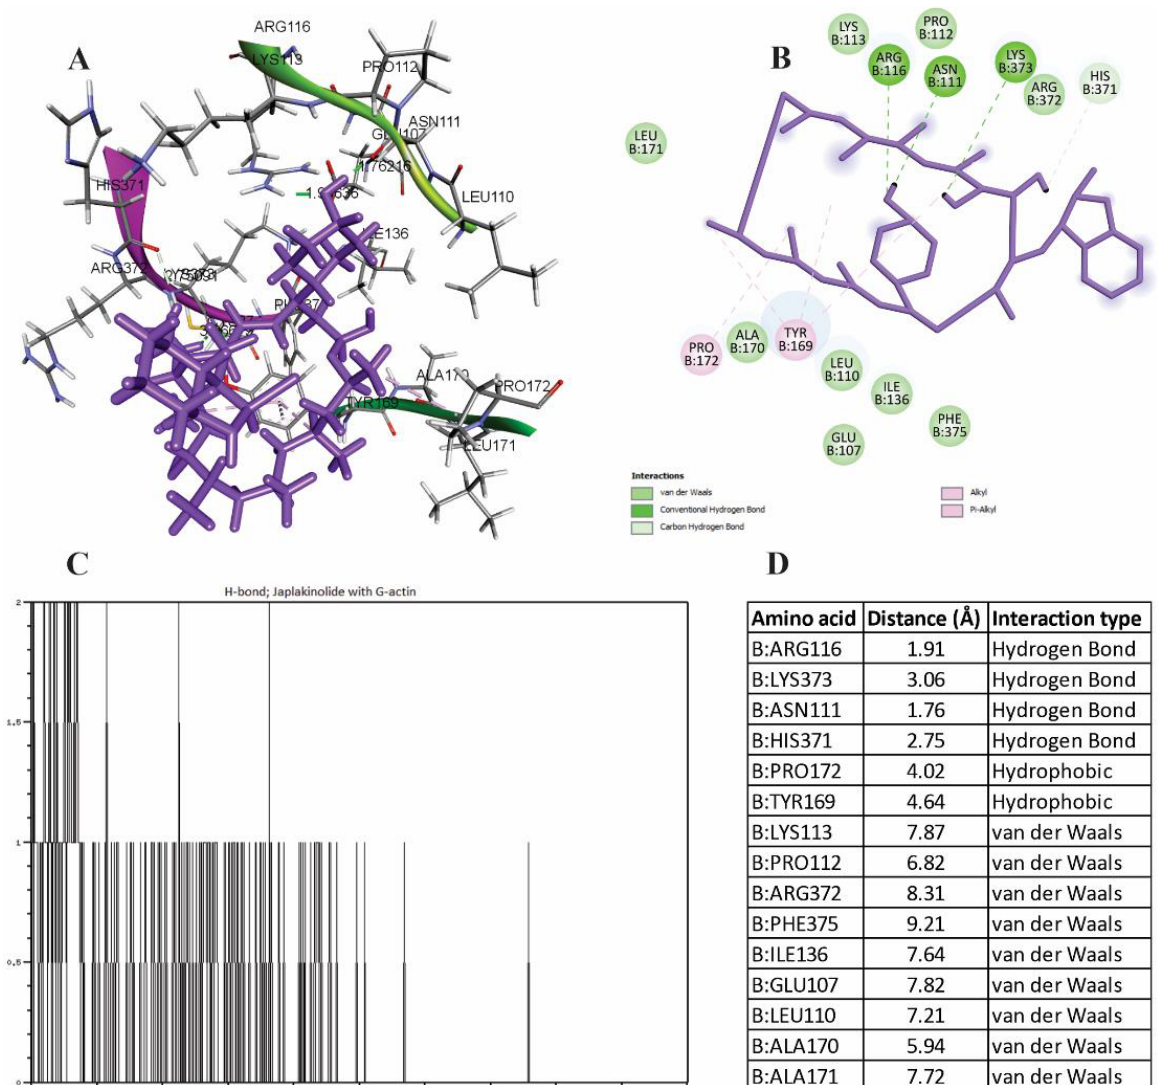
Figure 6. Spatial properties of jasplakinolide – G-actin complexation. ( A ) The spatial arrangement of jasplakinolide in the C-terminal loop of G-actin. ( B ) Conformational map of the complexation of jasplakinolide with G-actin. ( C ) The number of hydrogen bonds during complexation. ( D ) The list of amino acids involved in the interaction.